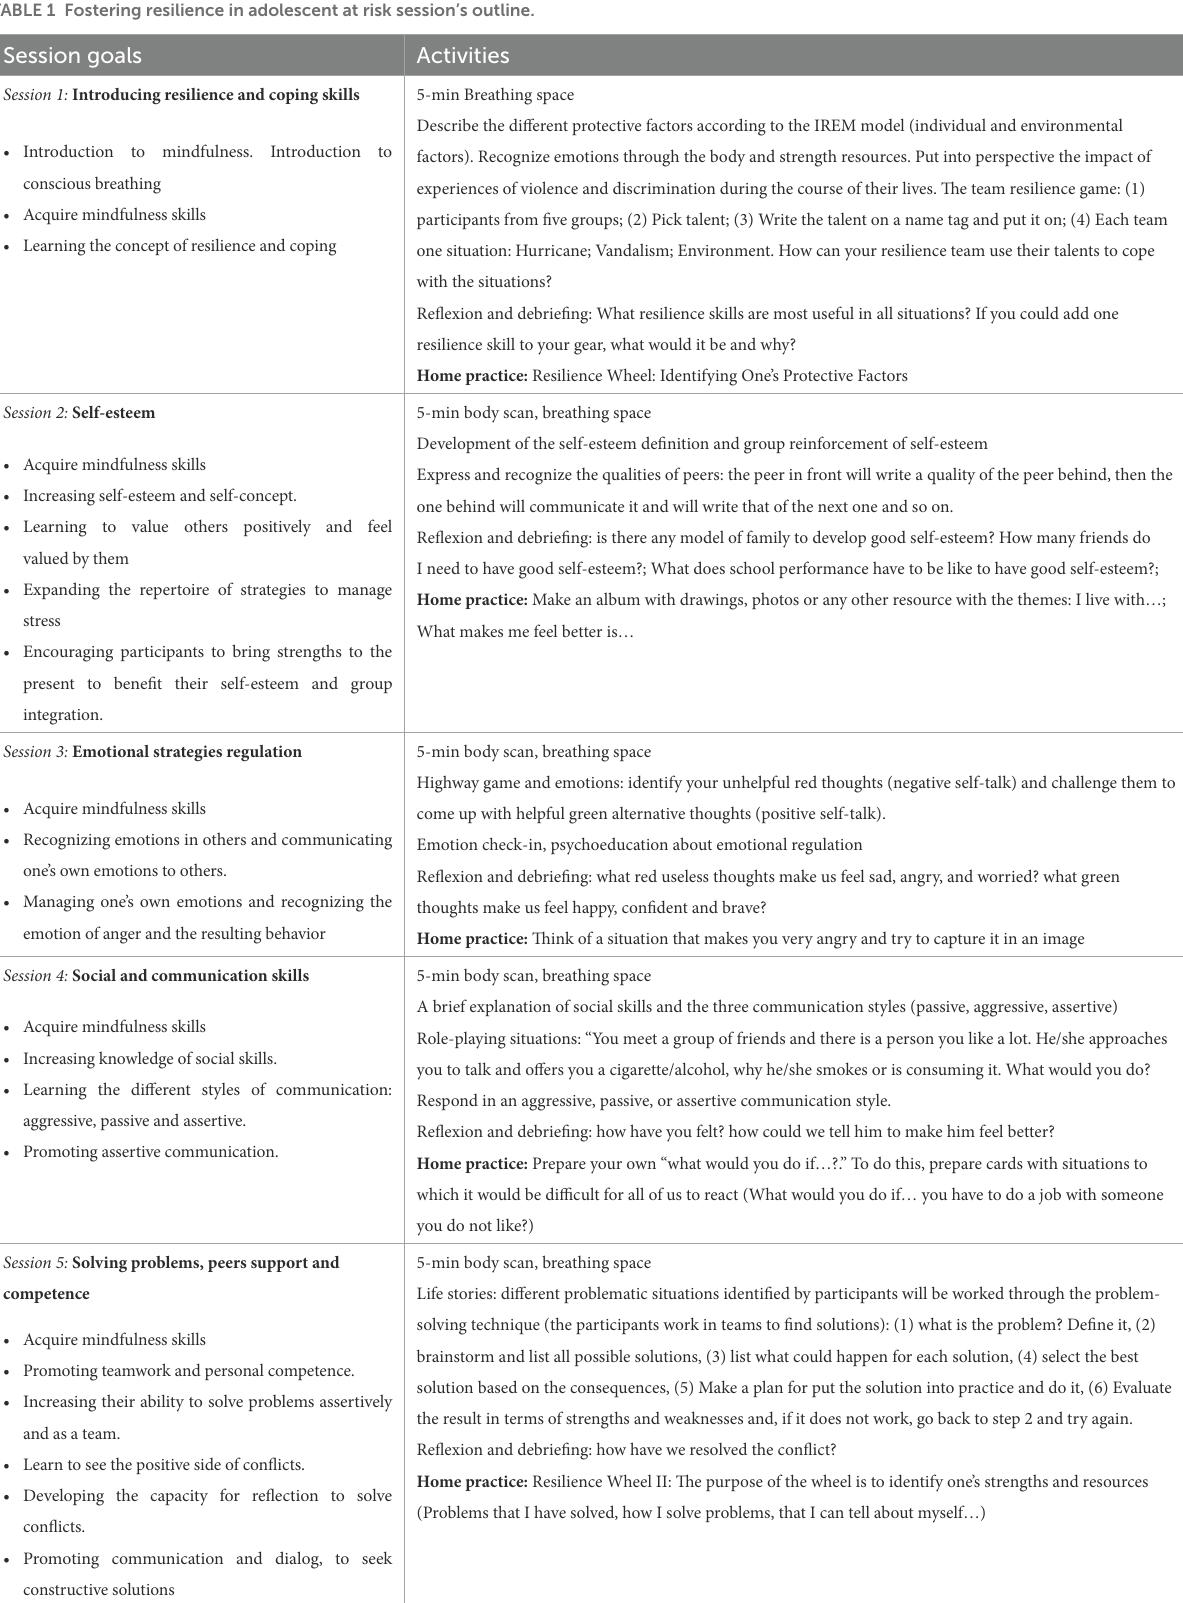
TABLE 1 Fostering resilience in adolescent at risk session’s outline. Session